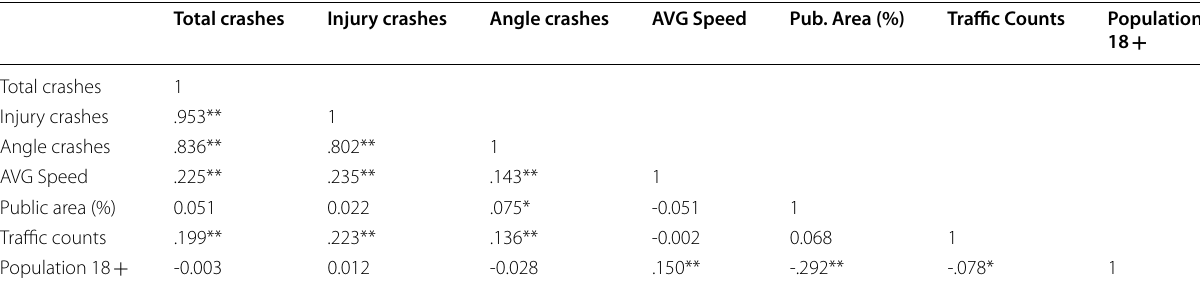
Table 4 Pearson correlation coefficients